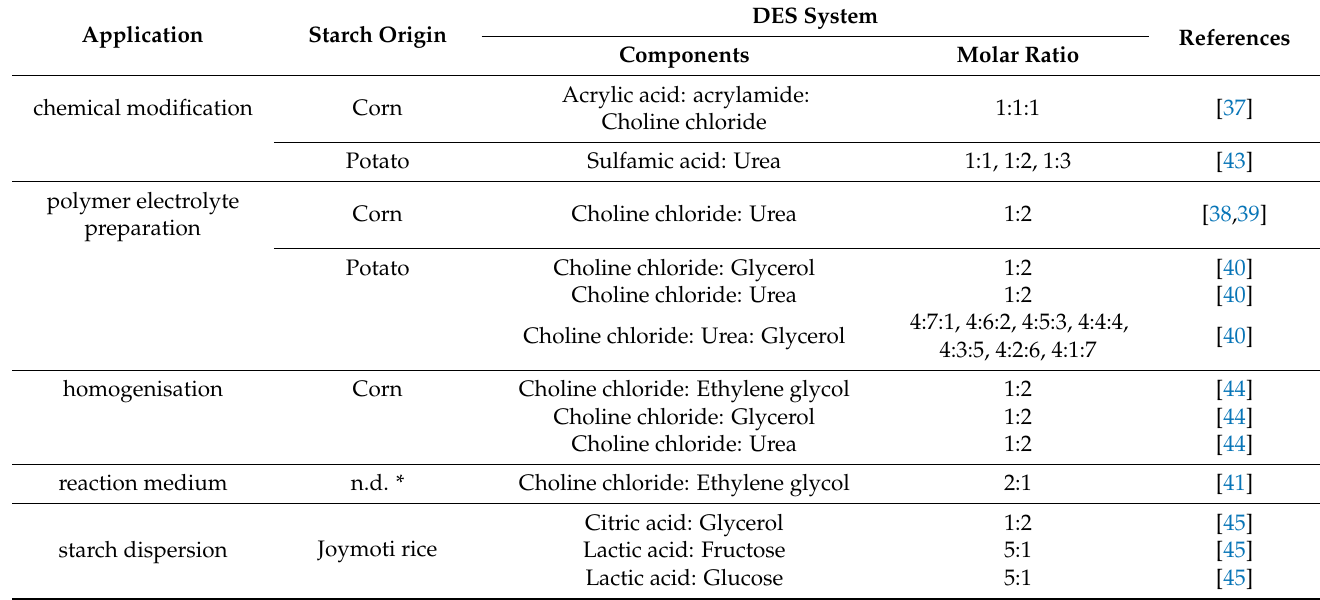
Table 3. Deep eutectic solvents for starch